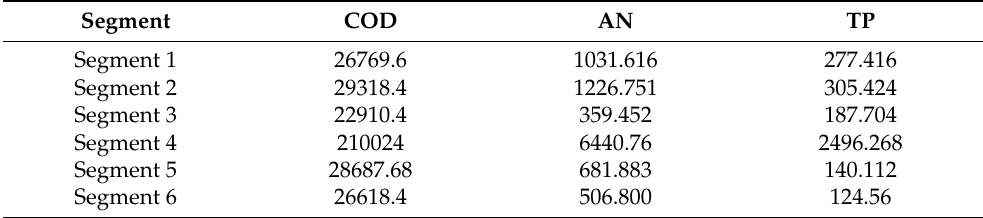
Table 2. Annual average total pollution load of COD, AN and TP in the Lushui River in 2019 (kg/d).